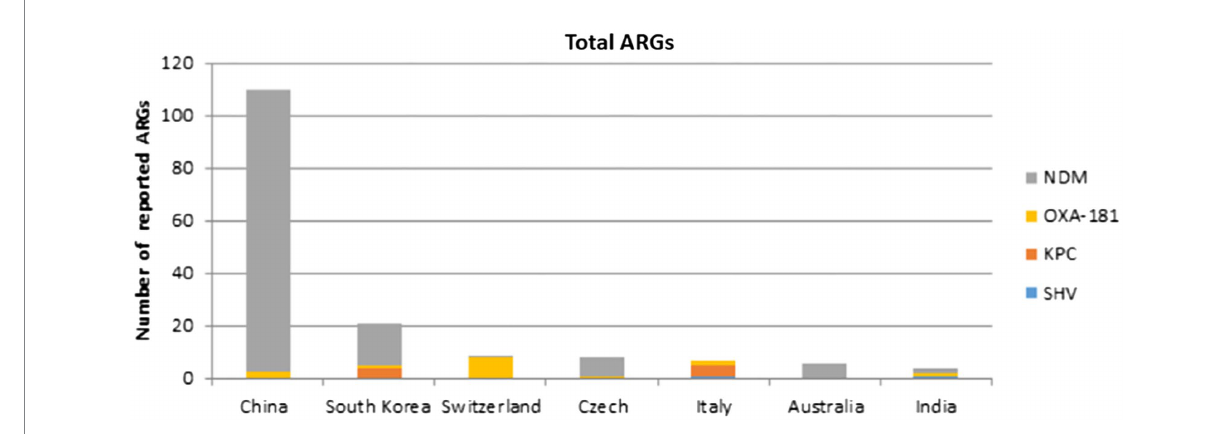
FIGURE 2 Number of carbapenemase genes reported in different countries represented by this review.